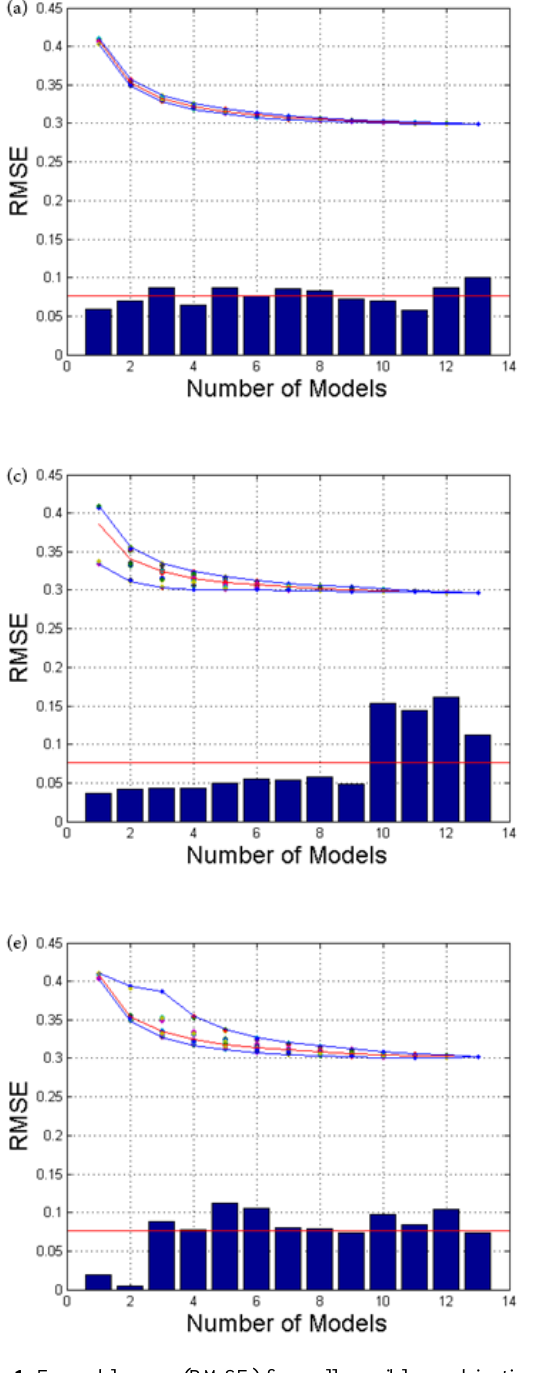
Figure 1. Ensemble error (RMSE) from all possible combinations of candidate models. The red curve on each plot represents the mean of the distribution of any k -model combinations while the blue curves form the min and max of the each respective distribution: (a) i.i.d., (b) bias perturbation, (c, d) variance perturbations, (e, f) covariance perturbations. Please read text for explanations and note the different range of the y -axis between the different panels. In the same plot, the bar chart expresses the optimal weight of each model in the full ensemble and the straight red line symbolizes the equal weight value. In this case, the horizontal axis represents the id of the